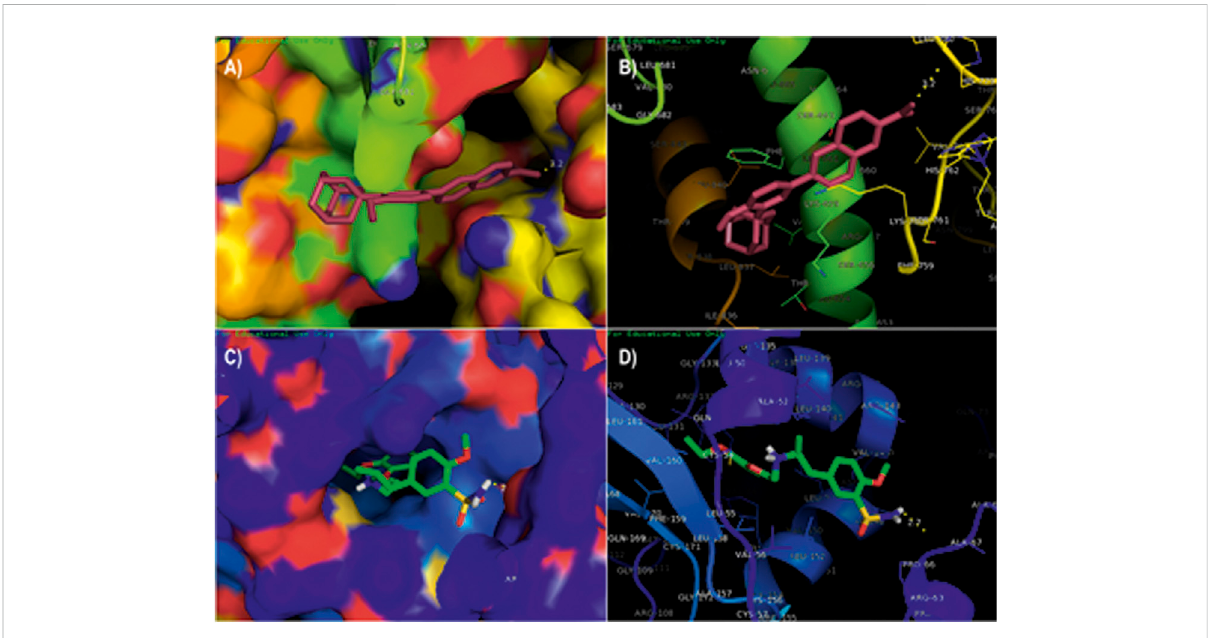
FIGURE 1 Molecular docking analysis of the top two ligands against the target protein hTERT. (A) Surface interaction of the ligand adapalene in the active binding site of the hTERT protein. (B) Molecular interaction of adapalene showing amino acid residues involved in the interaction. (C) Surface interaction of ligand tamsulosin in the active binding site of hTERT protein. (D) Molecular interaction of tamsulosin showing amino acid residues involved in the interaction.